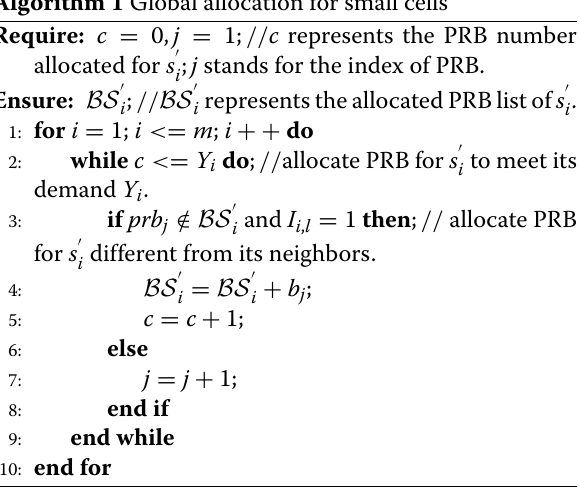
Algorithm 1 Global allocation for small